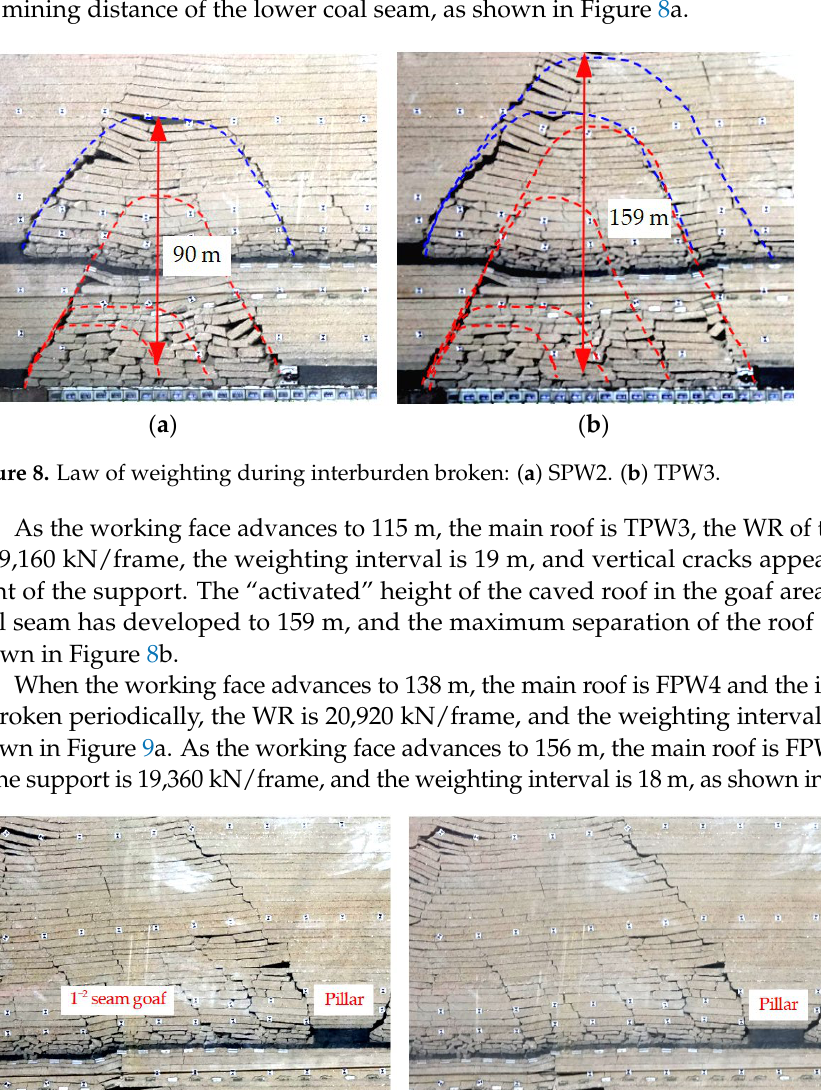
( b ) Figure 7. Law of weighting during the interburden unbroken: ( a ) FW. ( b ) FPW1. 4.2. When the Interburden Is Broken, Upper and Lower Goaf Are Connected When the working face advances to 96 m, the interburden is broken, the upper and lower goaf are connected, and the main roof is SPW2. The WR is 17,640 kN/frame, and the